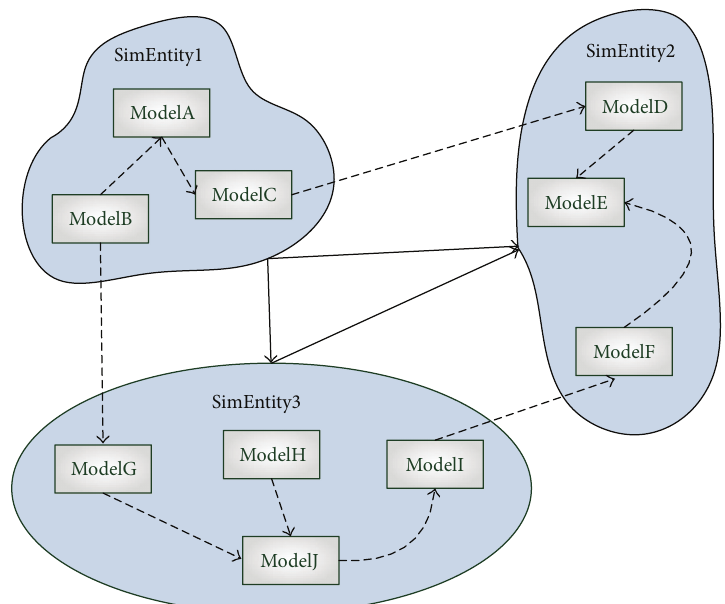
Figure 5: Communication between component models.